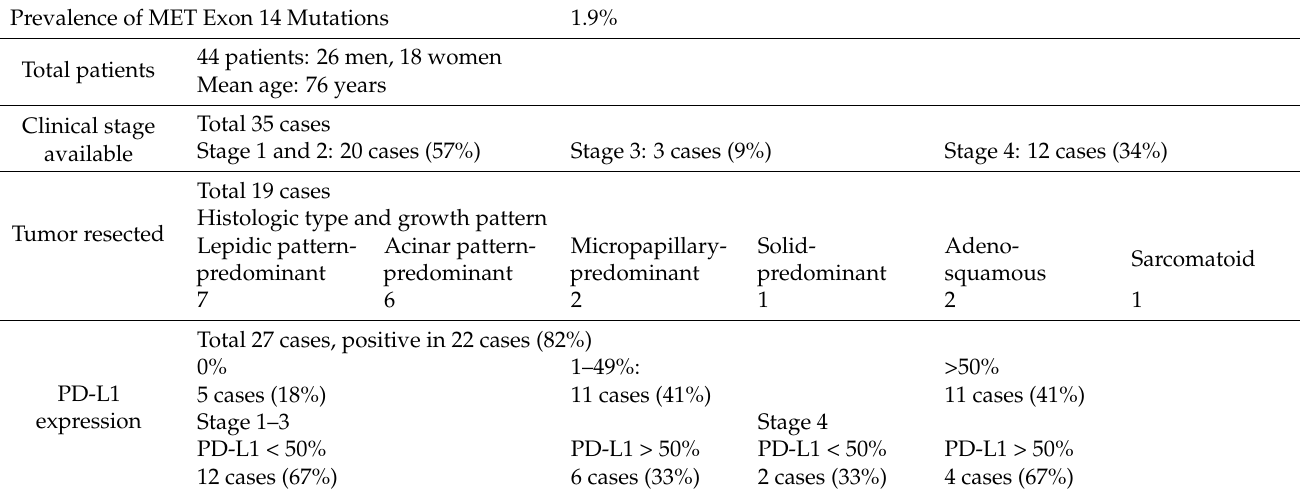
Table 1. Clinicopathologic correlation of tumors with METex14